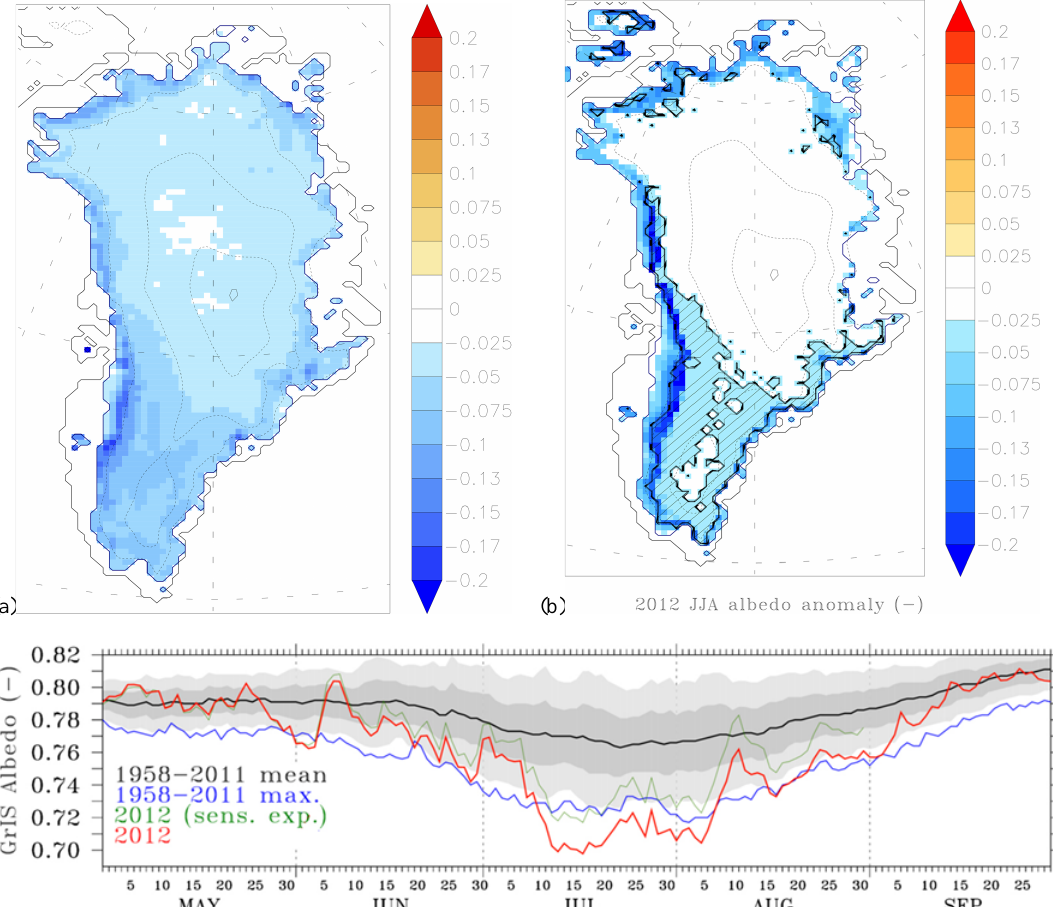
Fig. 7. (a) JJA MODIS albedo anomaly map following Box et al. (2012) for 2012 (using the 2000–2011 mean). MODIS data are re-projected onto MAR grid for graphical consistency purposes. (b) JJA MAR albedo anomaly map for 2012 (with respect to the 1958–2011 period). (c) Same as Fig. 6e but for